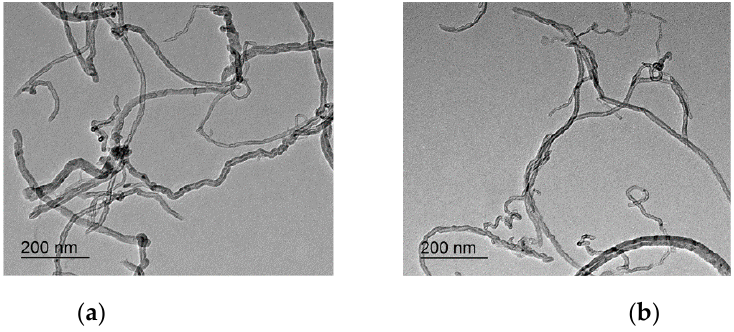
Figure 5. TEM micrographs of neat CNTs ( a ) and CNTs–OH ( b ) dispersed in water.